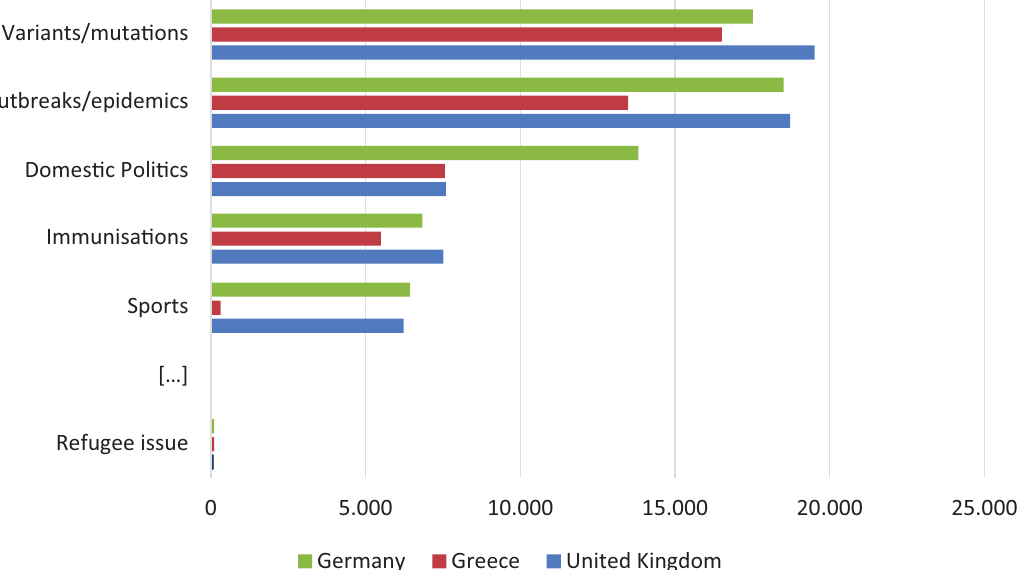
Figure 1. Most mentioned subjects related to Covid‐19 (number of articles). Source: Authors’ own compilation through Factiva.